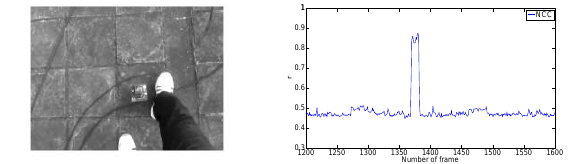
Figure 4. An example of an RN treated as a landmark extracted from an image with the NCC approach.